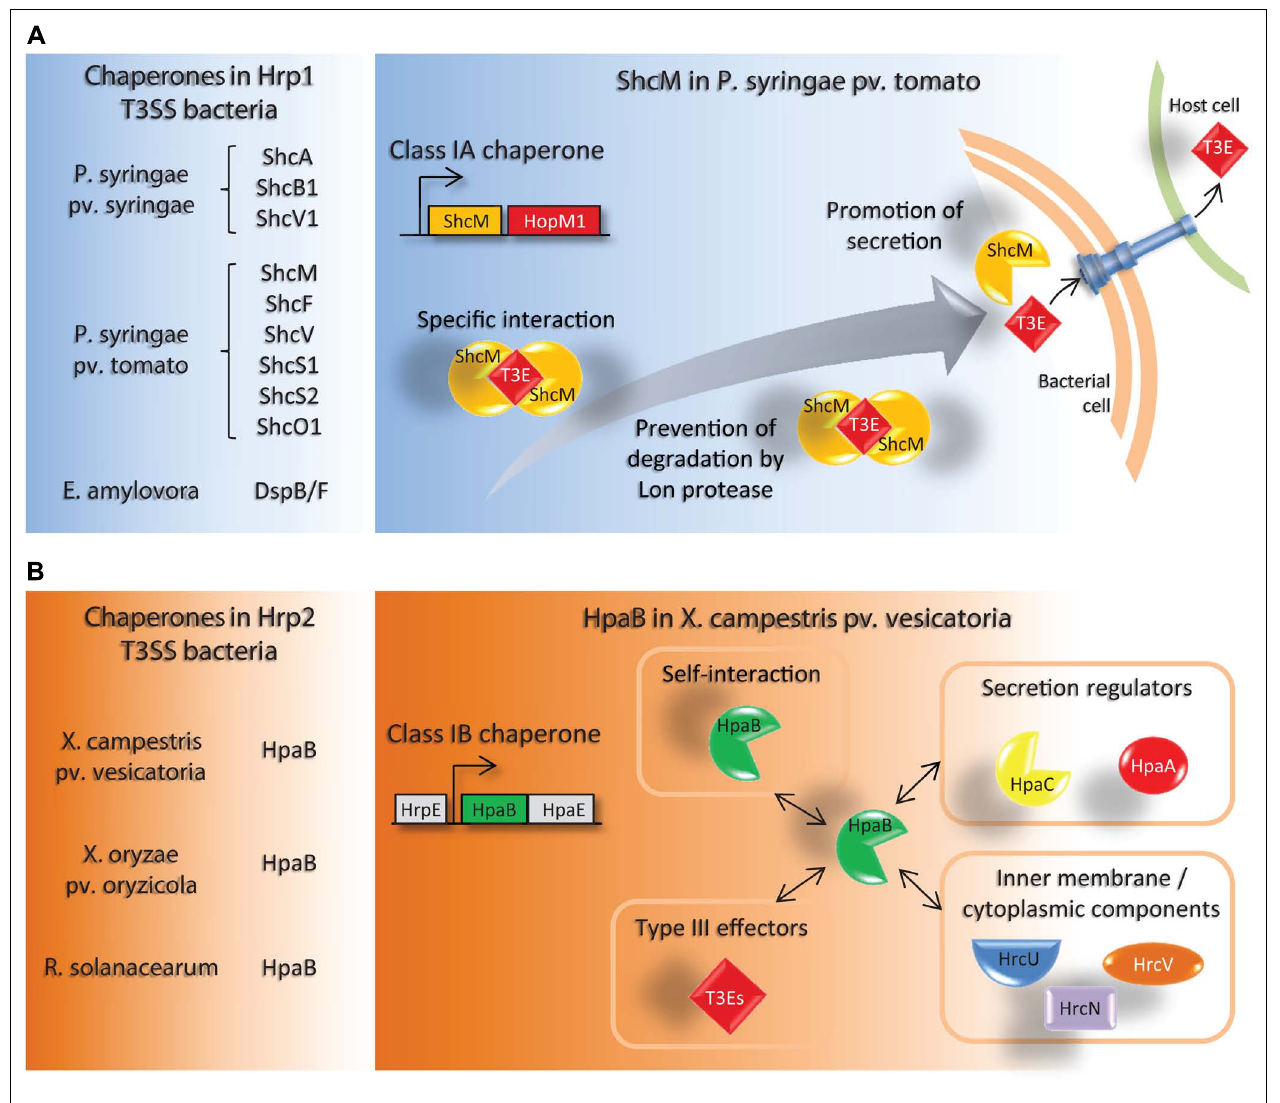
FIGURE 1 | Schematic representation of specific features of class IA and class IB T3Cs in plant pathogenic bacteria. (A) List of known T3Cs in Hrp1 T3SS bacteria (left panel). All are class IA T3Cs. A model depicting the role of the T3C ShcM is shown as a representative example (right panel). ShcM is co-transcribed with its cognate T3E HopM1. ShcM specifically interacts with HopM1, prevents its degradation by Lon proteases in the bacterial cytoplasm and promotes its secretion/ translocation via the T3SS. (B) List of known T3Cs in Hrp2 T3SS bacteria